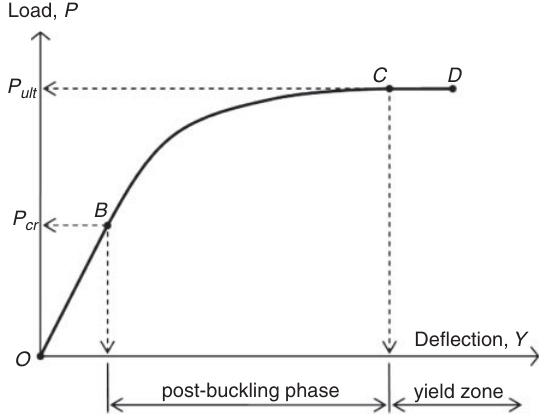
Fig. 4. Construction of load-de fl ection behaviour